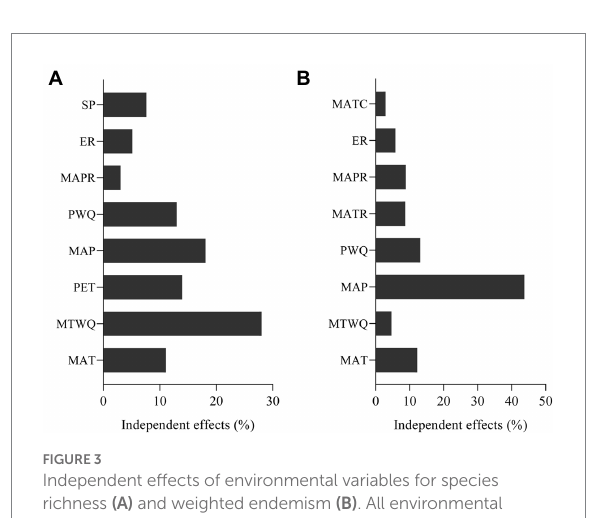
FIGURE 3 Independent effects of environmental variables for species richness (A) and weighted endemism (B) . All environmental variables were